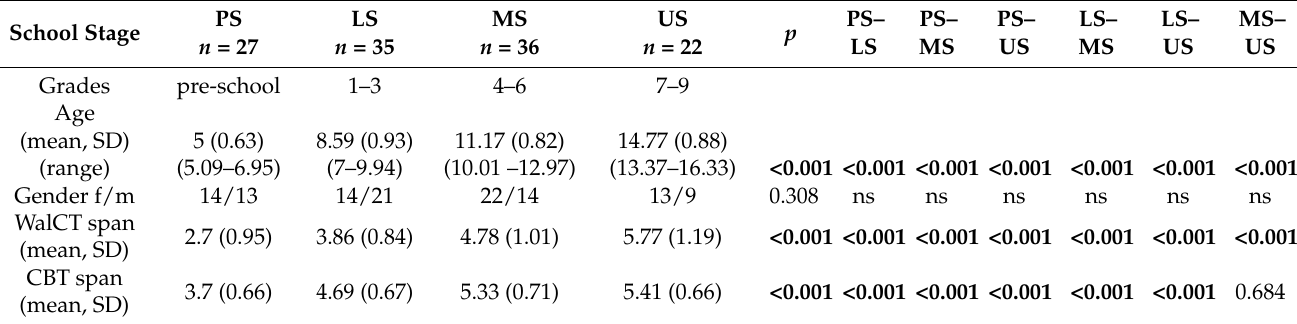
Table 1. School stages, demographics, mean, standard deviations (SD) (range), age, and spans of WalCT and CBT. PS = pre-school, LS = low stage, MS = middle stage, US = upper stage, f = female, m = male, and ns = non-significant. Significant results are marked in bold